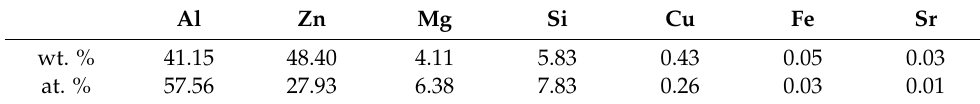
Table 1. Chemical composition of the alloy analyzed by ICP.